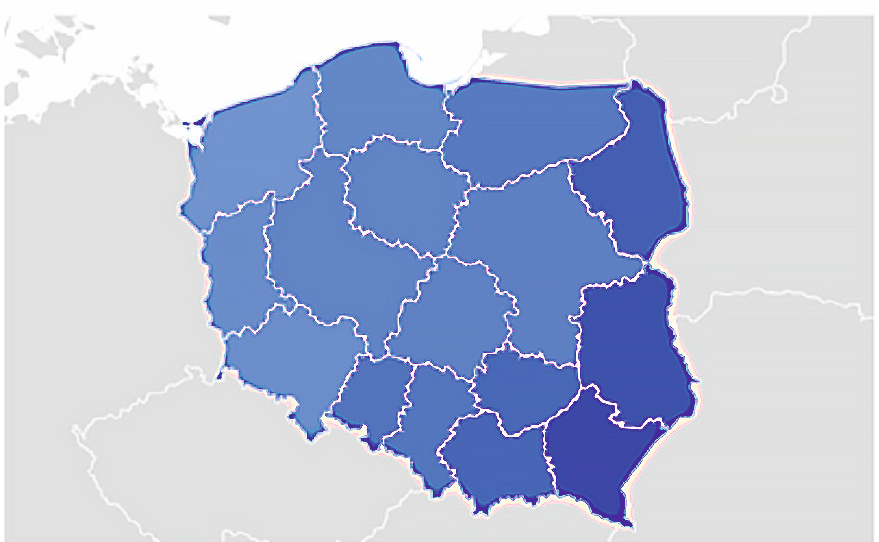
Figure 9. Frequency of searches for “prayer” over the last five years by region. Google Trends, https://www.google.com/trends (accessed on 23 August 2021).